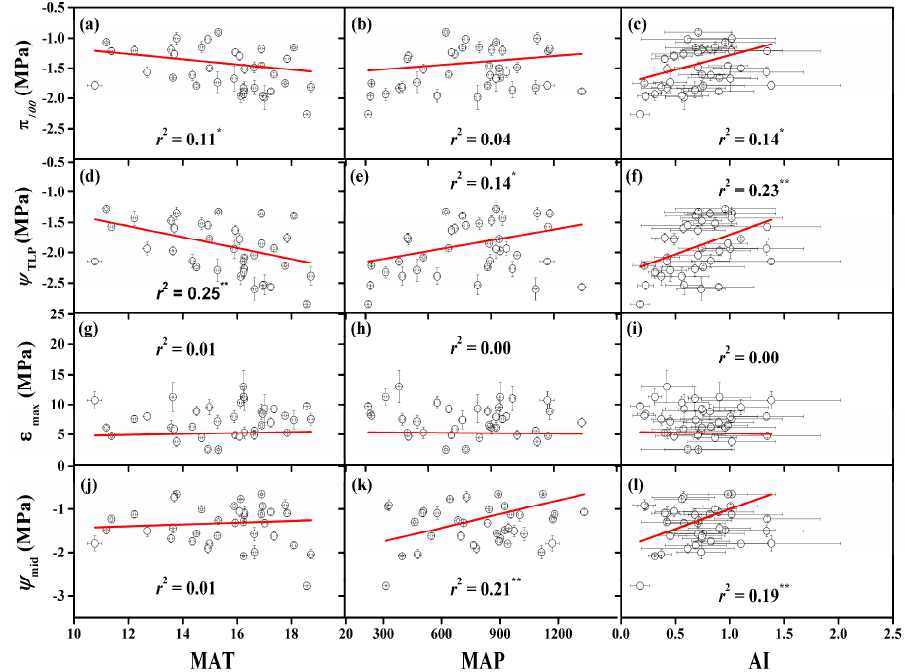
Figure 3. Correlations between each of three traits, annual mean temperature (MAT), mean annual precipitation (MAP), and annual aridity index (AI), at each species’ natural geographical distribution and ( a – c ) osmotic potential at full turgor ( π 100 ), ( d – f ) turgor loss point ( Ψ TLP ), ( g – i ) modulus of elasticity ( ε max ), and ( j – l ) midday leaf water potential ( Ψ mid ). Solid lines represent the linear regressions and associated r 2 values are provided (* P < 0.05, ** P < 0.01, *** P < 0.001). Data are means ± 1 SE.